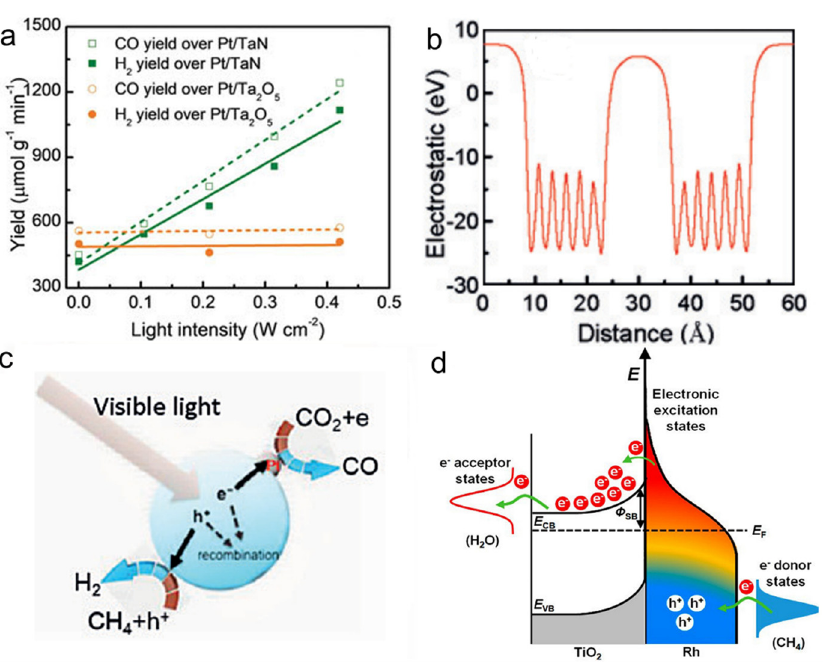
Figure 6 . ( a ) Catalytic performance of Pt/TaN and Pt/Ta 2 O 5 for DRM reaction to produce CO and H 2 . ( b ) The distribution of the electrostatic field over TaN, and ( c ) Proposed mechanism of the DRM reaction over Pt/TaN catalyst under visible light irradiation. Reprinted with permission from ref. [135]. Copyright 2018 Wiley-VCH. ( d ) Schematic of energy transfer from photoexcited hot carriers to adsorbate states and proposed mechanism for SMR reaction on Rh/TiO 2 under illumination. Reprinted with permission from ref. [138]. Copyright 2018 American Chemical Society.